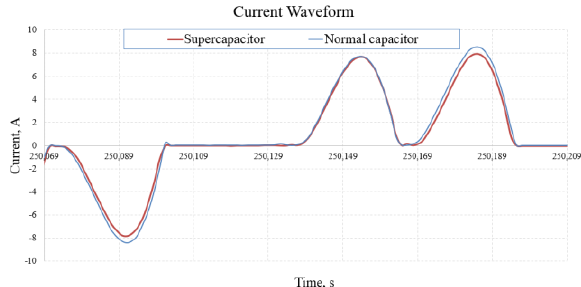
Figure 9. Current waveform on the input of frequency converter